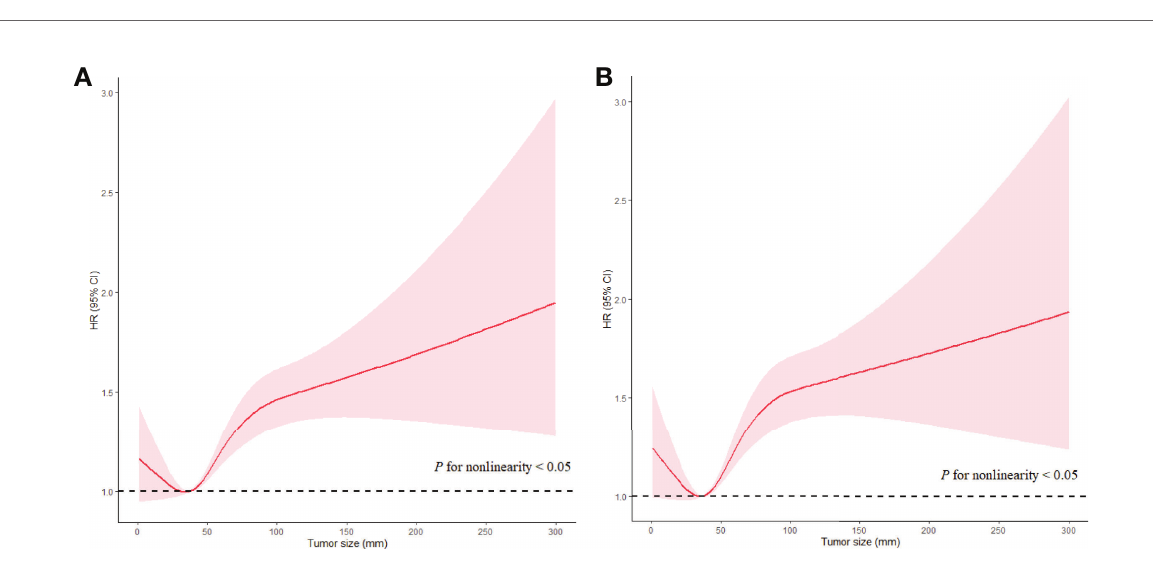
FIGURE 4 | Associations of Ts with prognosis in EC patients without LNM in RCS with Cox models after adjustment. Red lines estimated HR of Ts; shadow area 95%CI. (A) Adjusted RCS model for ACD. (B) Adjusted RCS model for